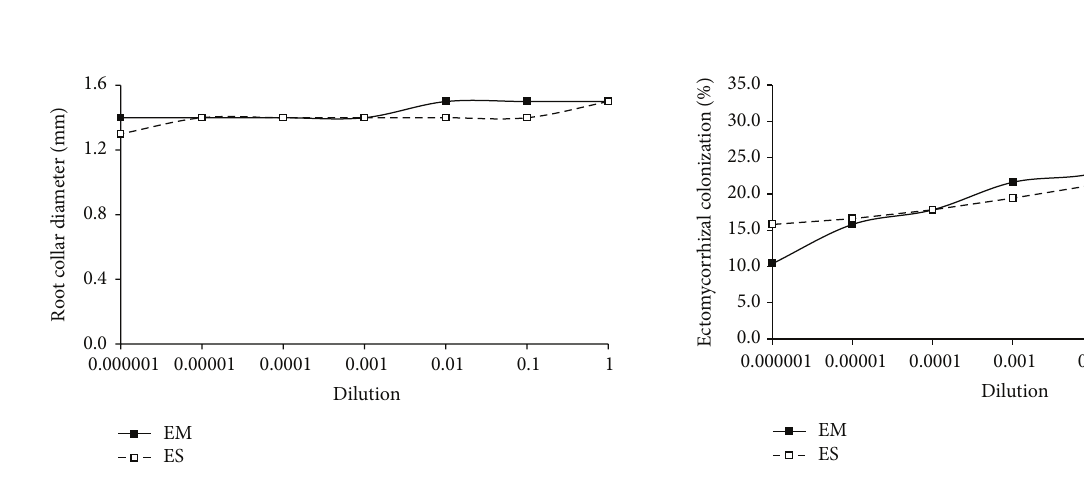
Figure 5: Root ectomycorrhizal colonization of P. patula seedlings for EM and ES inocula at each level of serial